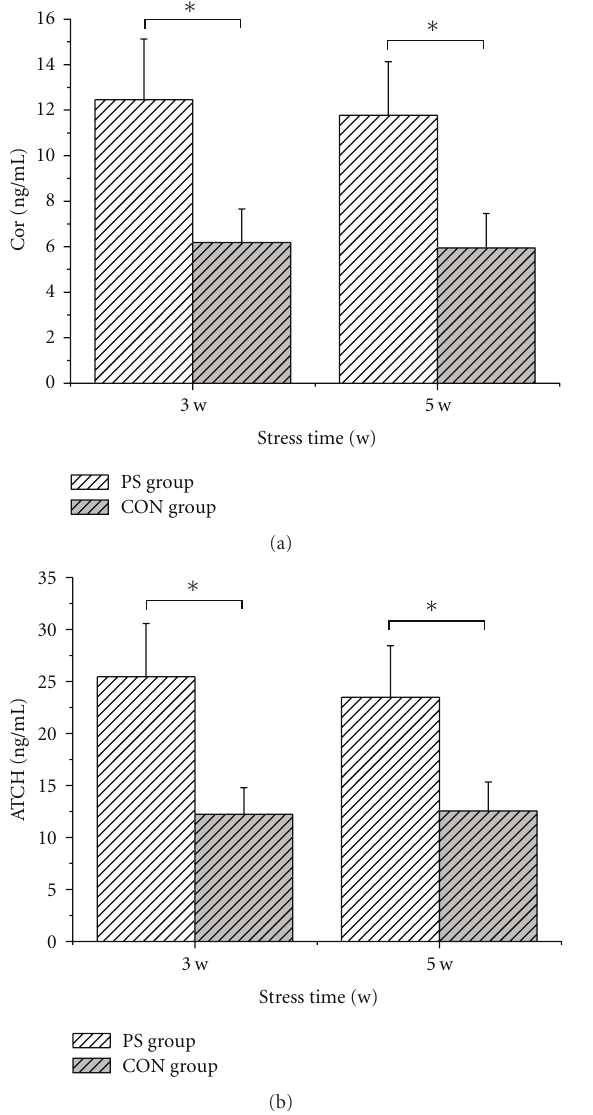
Figure 2: The levels of cortisol and adrenocorticotropic hormone in serum. Shown are the levels of cortisol (Cor, in (a)) and adrenocorticotropic hormone (ACTH, in (b)) in the serum of rats in the psychological group (PS) and control group (CON). Data were expressed as X ± SE and analyzed in eight rats from each group ( ∗ P < .05, PS group versus CON group).